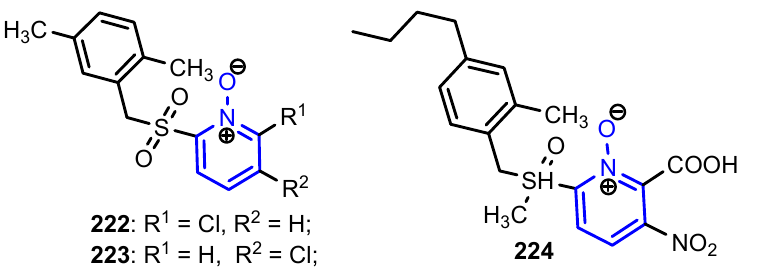
32 of 41 Table 14. In vitro antitubercular activity of compounds 220a and 221 in comparison to some refer- ence drugs. Compound - 11. Synthesis of Antiviral Pyridine Compounds In recent years, several important viral infections have emerged and antiviral chemo- therapeutic agents are not sufficiently effective in clinic, leading to serious human diseases and mortality. Therefore, novel antiviral candidates are urgently desirable, which is un- doubtedly essential for the therapy of various fatal viral infections. Pyridine compounds are obtaining importance in the field of medicinal chemistry because of the broad spec- trum of their physiological activities. In this part of the review is highlighted antiviral behavior of pyridine compounds [96]. The pandemic of coronavirus disease 2019 (COVID- 19) caused by the novel severe acute respiratory syndrome coronavirus 2 (SARS-CoV-2) presents an unprecedented challenge to identify effective drugs for prevention and treat- ment [97]. Balzarini et al. [98] reported the synthesis of pyridine N-oxide derivatives and the inhibitory effect of these compounds on human SARS and feline infectious peritonitis coronavirus in cell culture. Thus, compounds 222 and 223 were the most interesting com-